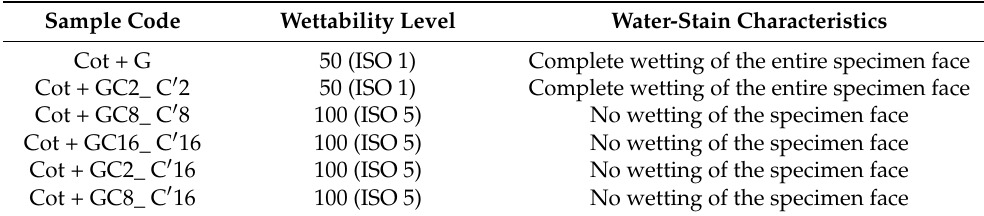
Table 5. Wettability levels specified in the ATTCC 22 standard for spray tests.